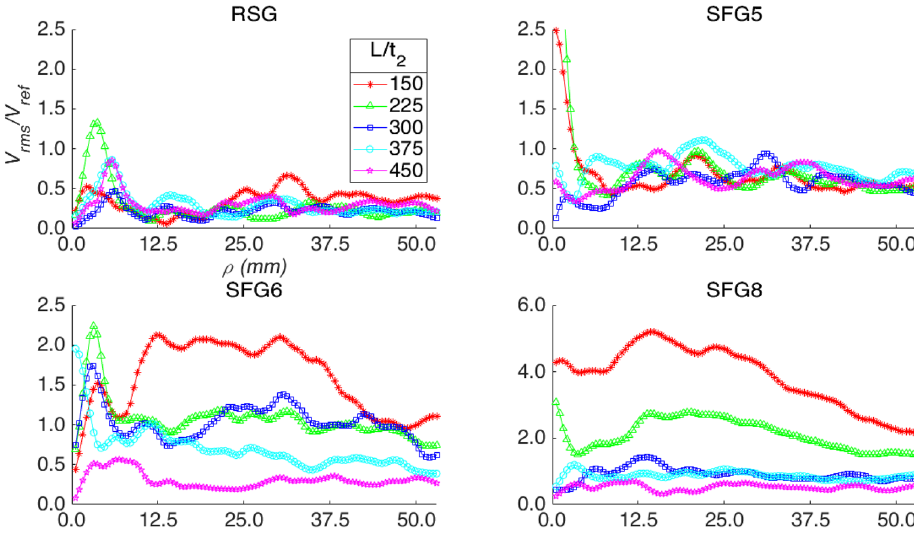
Figure 4. Normalized V rms averaged across each concentric square, ρ . Note: The Y -axis scale for RSG, SFG5 and SFG6 is from 0 to 2.5 while SFG8 is 0 to 6. (note: prepared in Matlab R2018A, https:// www. mathw orks. com/ produ cts/ matlab.